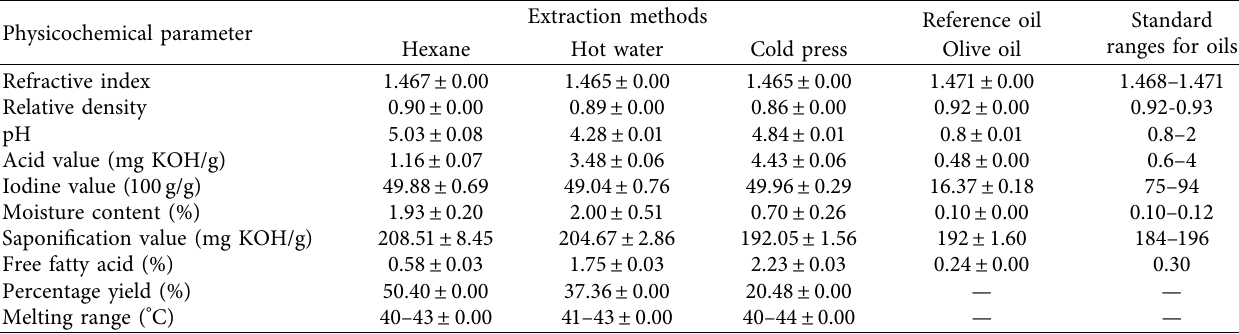
Table 1: Te physicochemical parameters assessed on A. foribunda butter extracted by hexane, cold press, and hot water compared to a reference standard (olive oil).